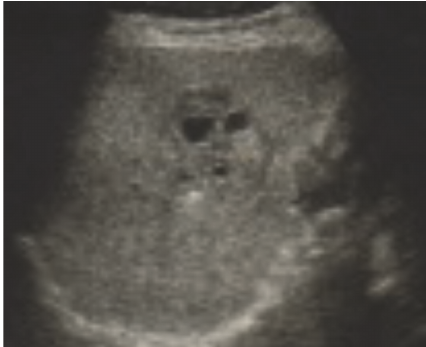
Figure 1: Ultrasonography (US) images. US showed an isoechoic nodule with small hypoechoic areas in segment 8 of the liver.